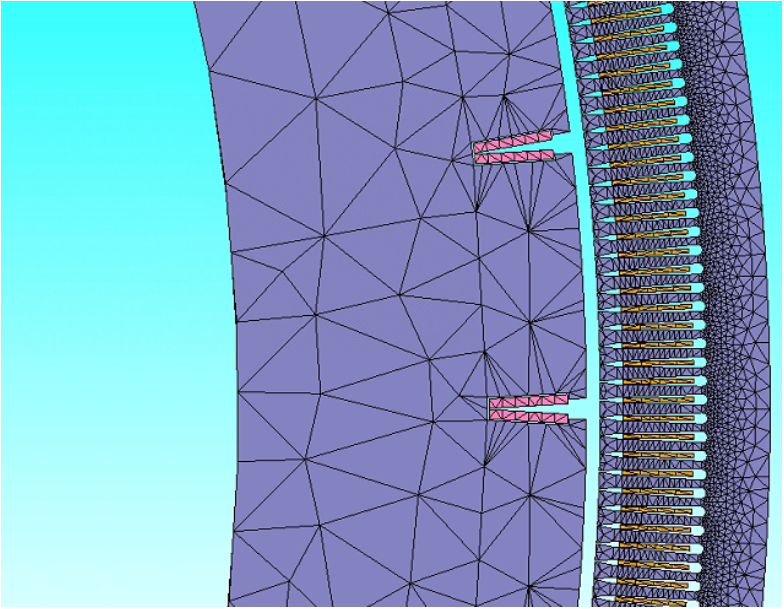
Figure 4. The mesh of the hydro-generator. (top